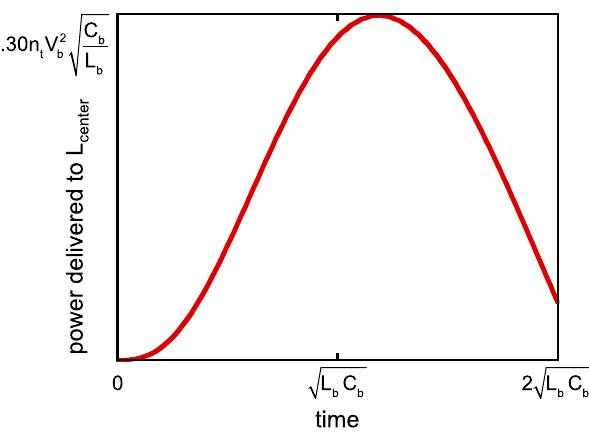
FIG. 16. Time history of the electrical power delivered to the inductance L of the idealized accelerator-circuit model center illustrated by Fig. 15, assuming Eqs. (C7) and (C12).